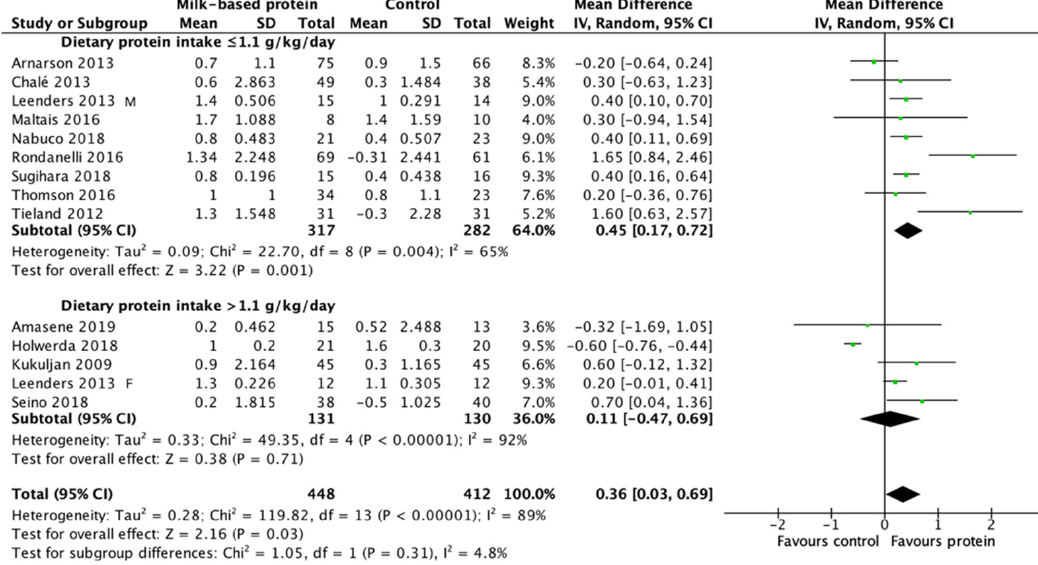
Figure 4. Forest plot for the differences in RT-induced LBM/FFM gain between consuming milk-based protein supplements and control supplements considering the subgroup analysis of daily dietary protein intake.